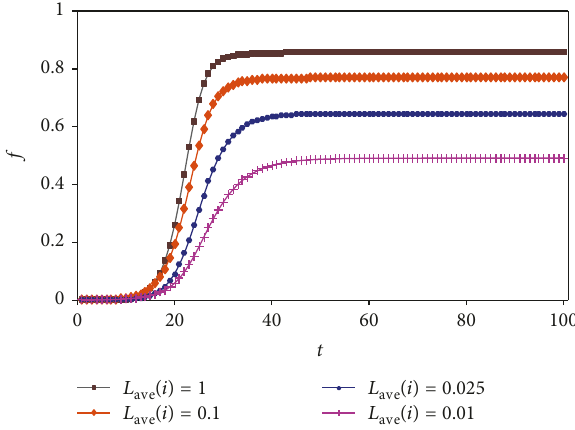
Figure 8: The evolution process of individuals with di ff erent average degree of association in simulation of Figure ave under